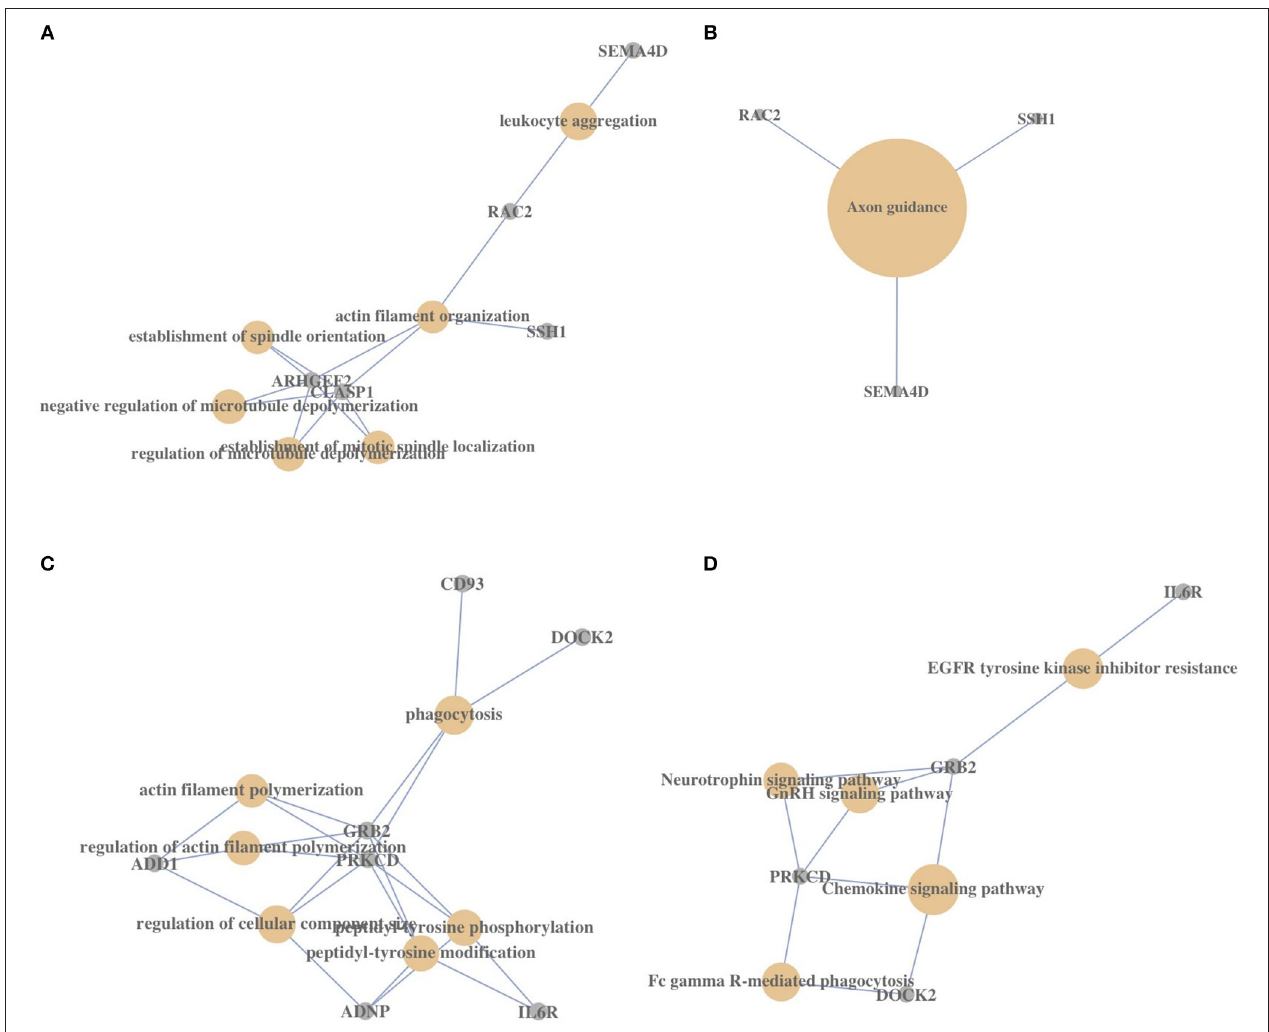
FIGURE 5 | The biological process and signal pathway enrichment of ZMIZ1 -associated gene clusters. (A) The GO BP terms enrichment for ZMIZ1 gene cluster 1. (B) The KEGG signal pathway enrichment for ZMIZ1 gene cluster 1. (C) The GO BP terms enrichment for ZMIZ1 gene cluster 2. (D) The KEGG signal pathway enrichment for ZMIZ1 gene cluster 2. Size of circle reflects the relative significance of p -value in each figure.